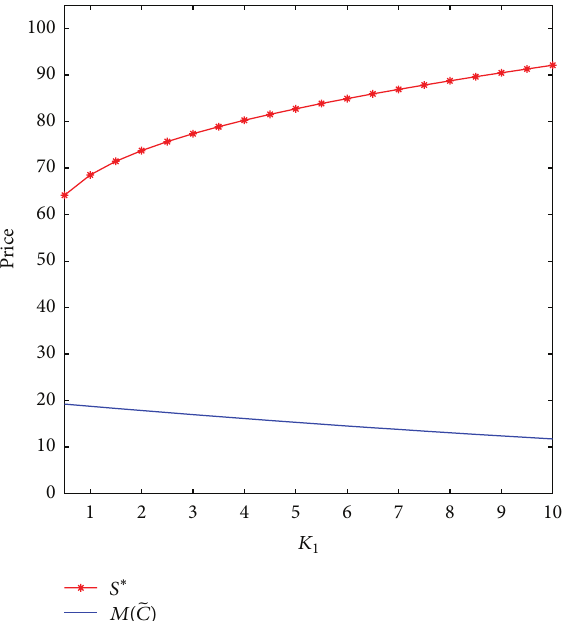
𝑀(̃𝐶) with respect to 𝑇 1